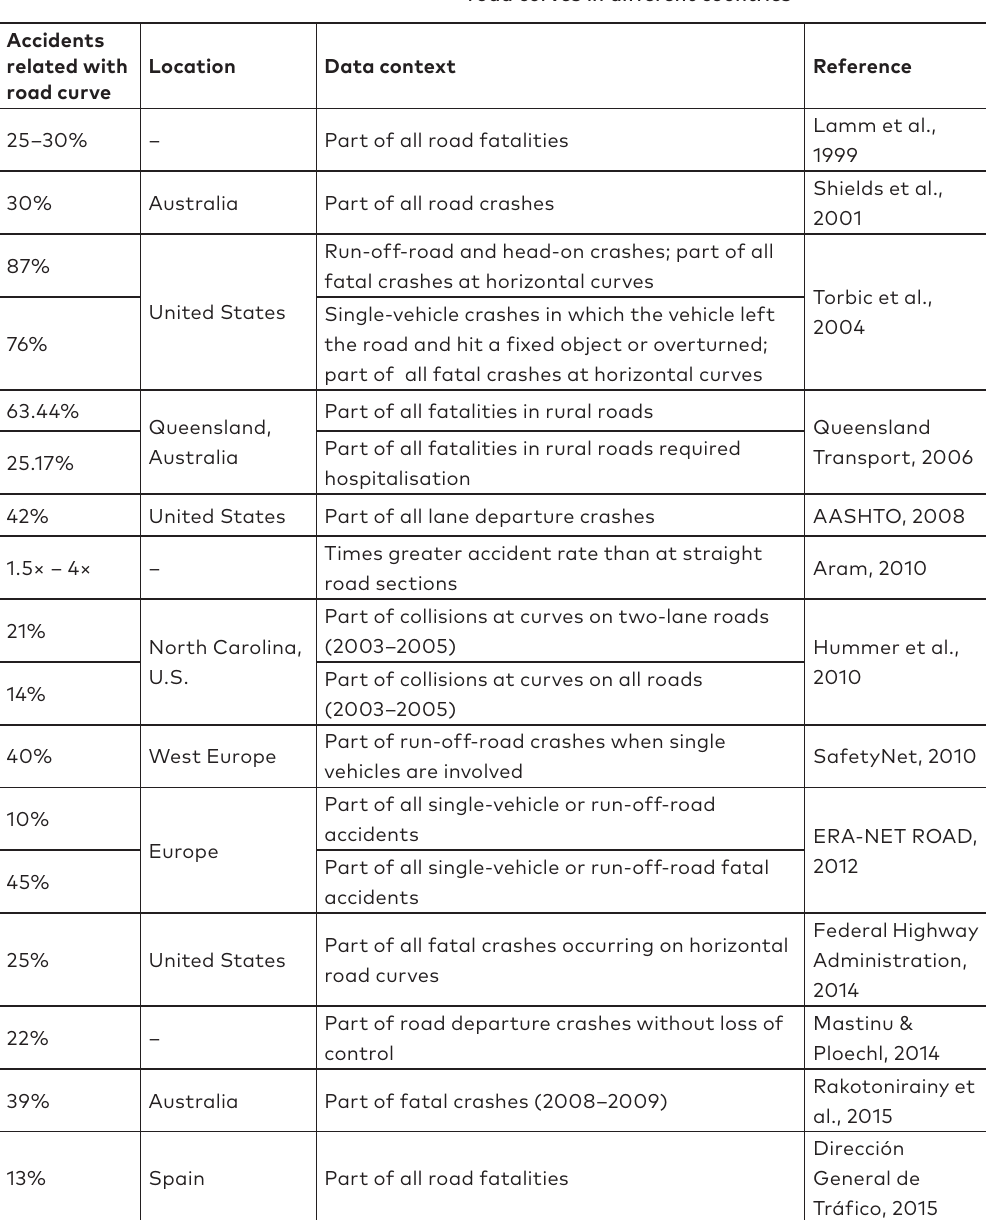
Table 1. Overview of accidents related to horizontal road curves in different